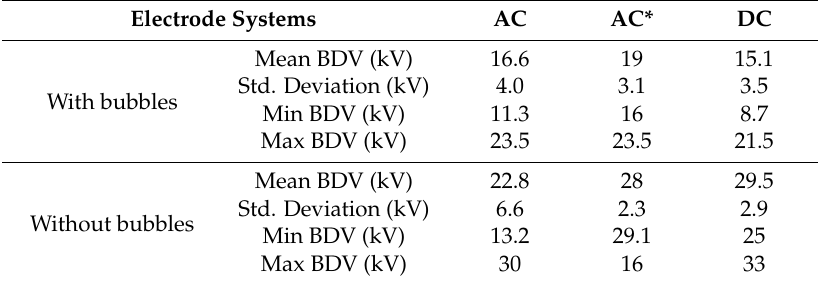
Figure 8. The breakdown progress of the cylinder-plan electrodes in the oil.